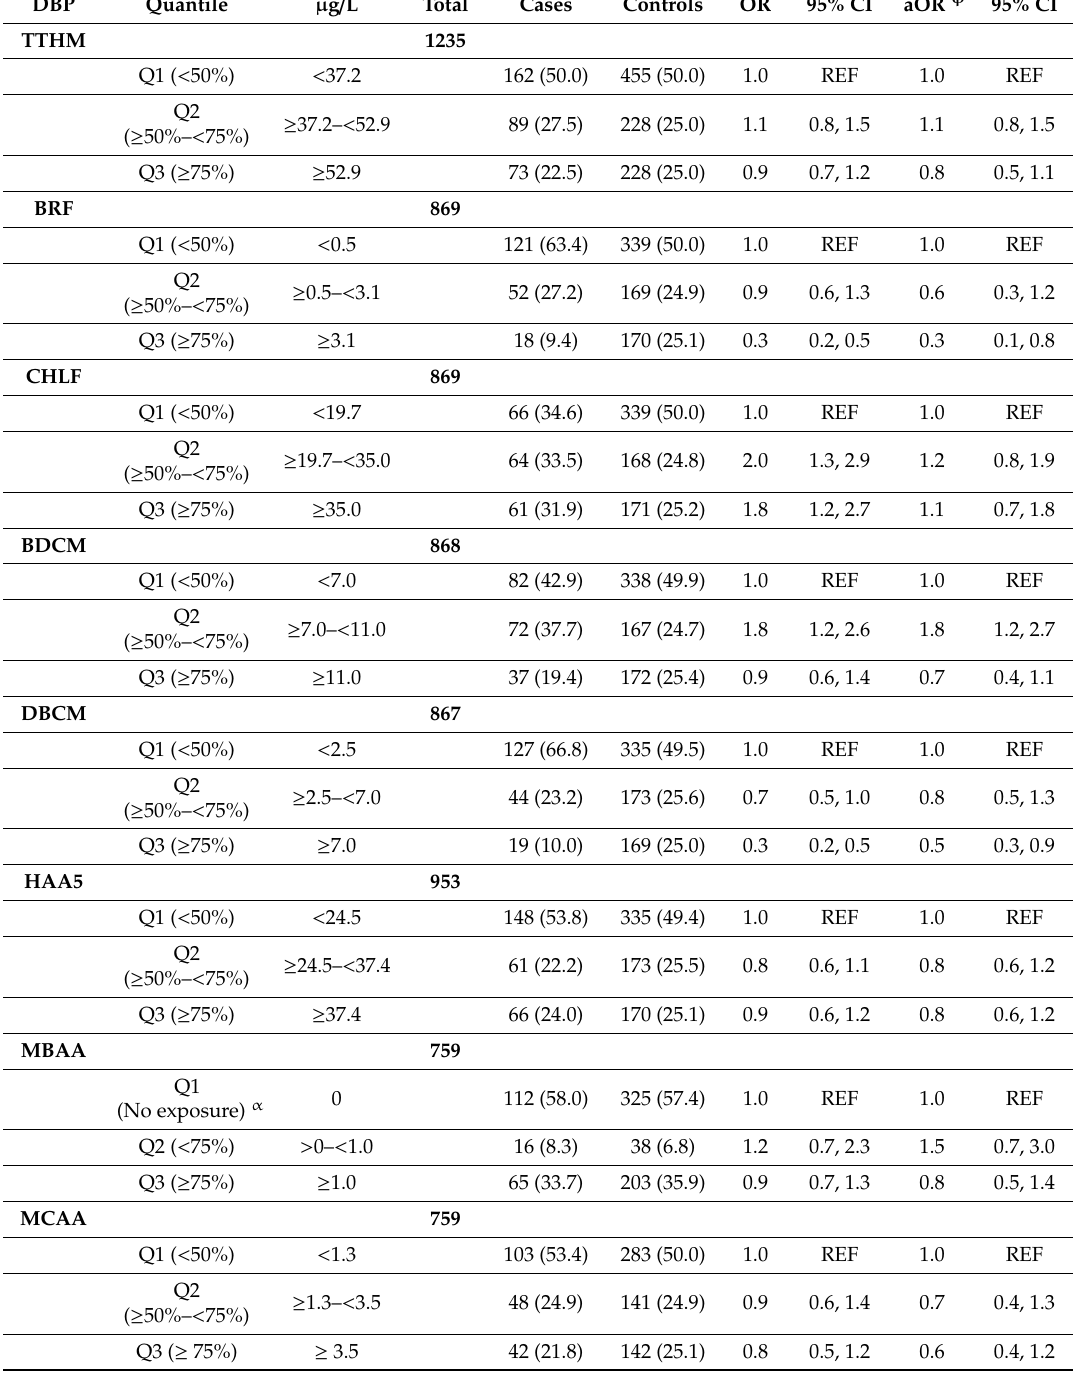
Table 2. Association between household disinfection by-product (DBP) concentrations and hypospadias, National Birth Defects Prevention Study, 2000–2005 ( n = 1247)